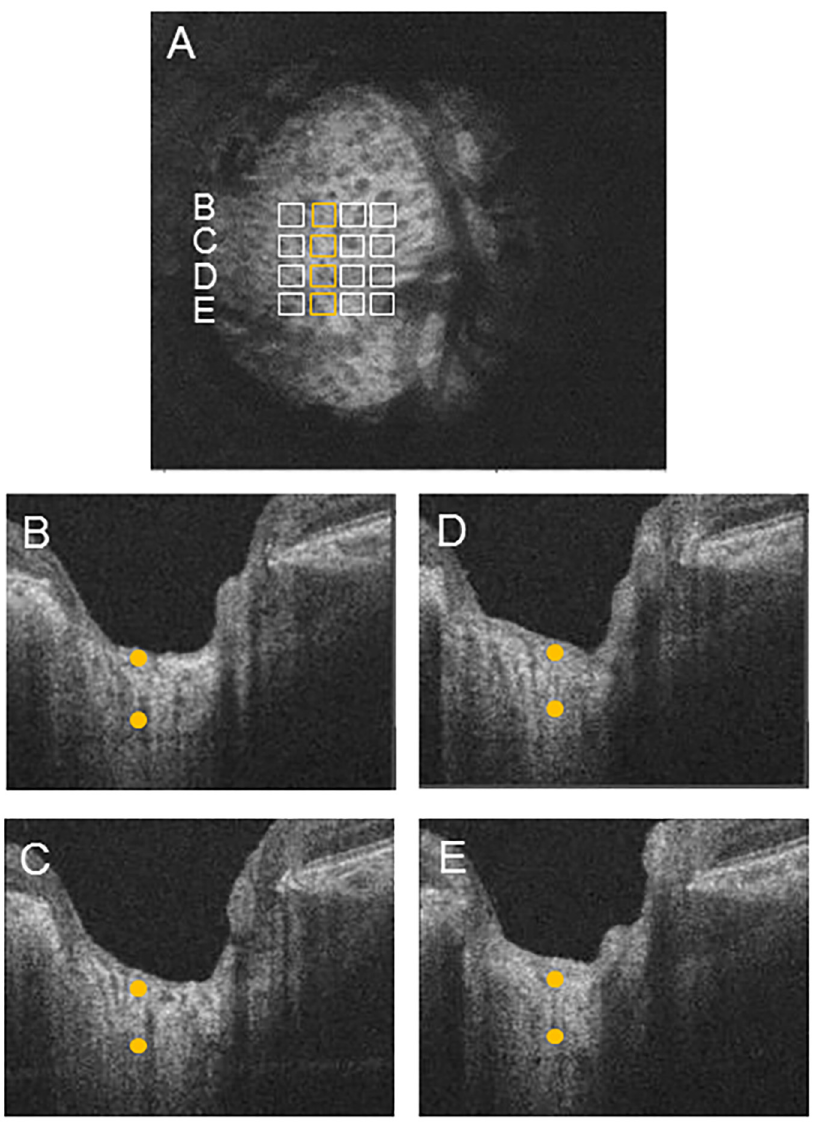
Fig 2. Simplified software technique for measuring lamina cribrosa (LC) thickness in a 4 x 4 grid. (A) 4 x 4 grid superimposed on an en-face image of the LC, showing the position of the B-scan images below. (B-E) Horizontal cross-sectional B-scan images, with orange dots indicating the anterior and posterior borders of the LC. Average LC thickness was defined as the average thickness in the 16 grid cells.